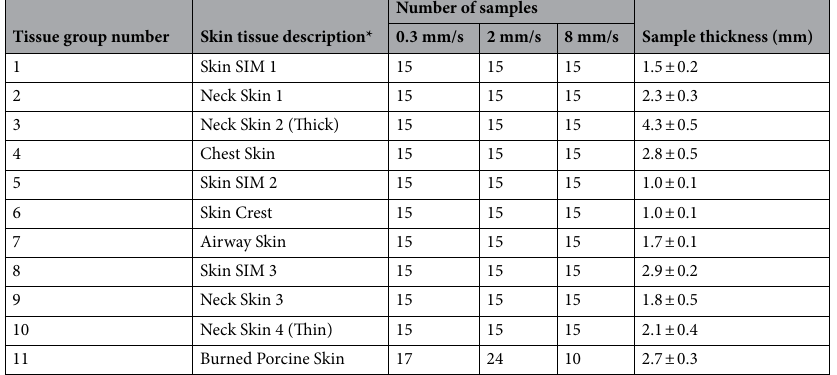
Table 1. Tissue groups and number of samples for the three loading rates. *This research is a comparison of material properties and does not constitute an endorsement nor a criticism of any commercial